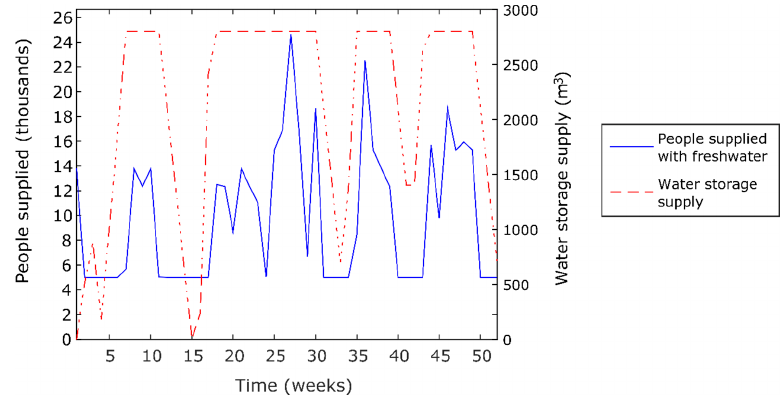
Figure 7. Number of people supplied with freshwater over one year using a water storage tank of 2800 m 3 .